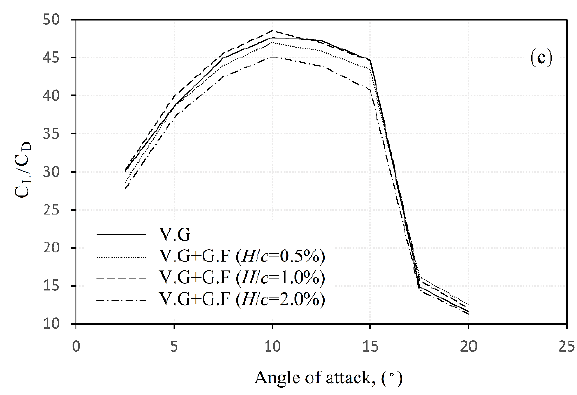
Figure 12. Lift coefficient, drag coefficient and aerodynamic performance for the airfoil equipped with VGs in the presence of Gurney flap